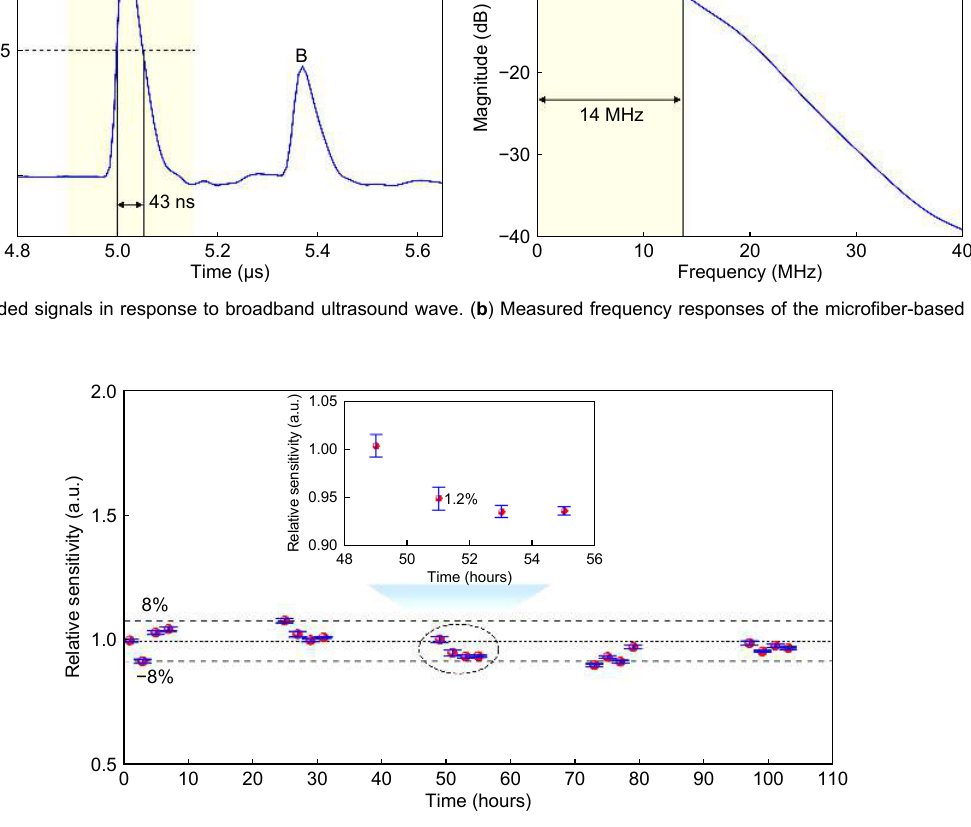
Fig. 5 | The short-term and long-term stability of the microfiber-based ultrasound